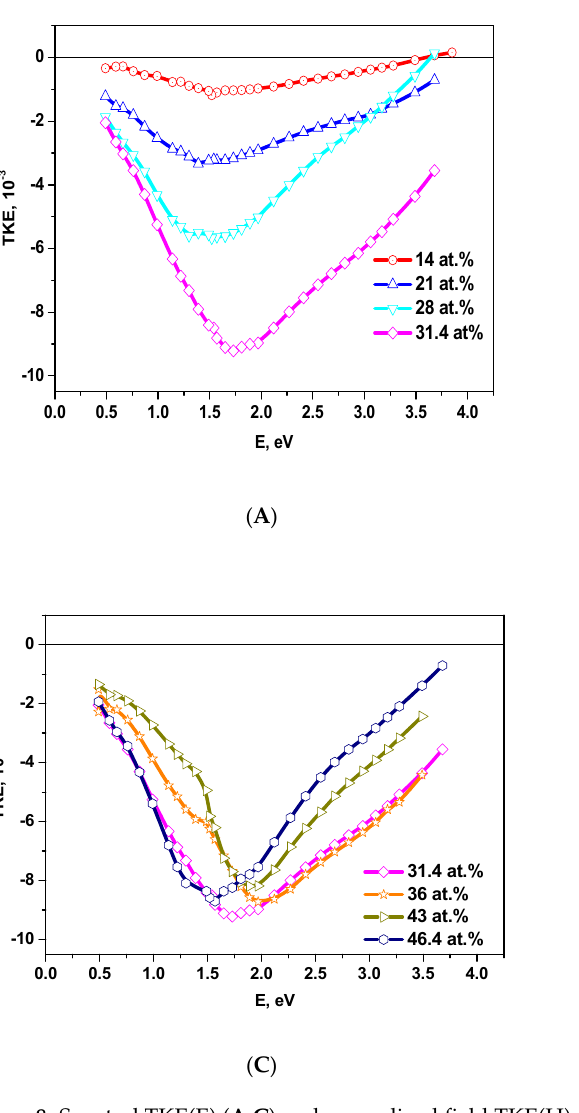
Figure 8. Spectral TKE(E) ( A , C ) and normalized field TKE(H)/TKE(Hmax) ( B , D ) dependences for nanocomposites on the glass-ceramics substrates with metal concentration less and greater x = 31.4 at.%.